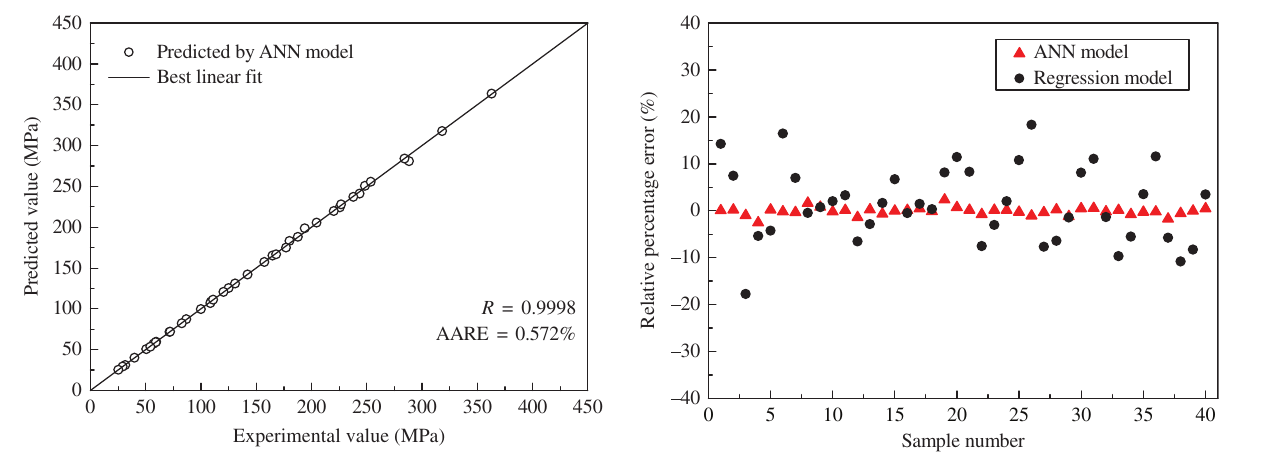
Figure 16 Comparison of relative percent error of predicted value by ANN and calculated value by regression model with experimental value at strain of